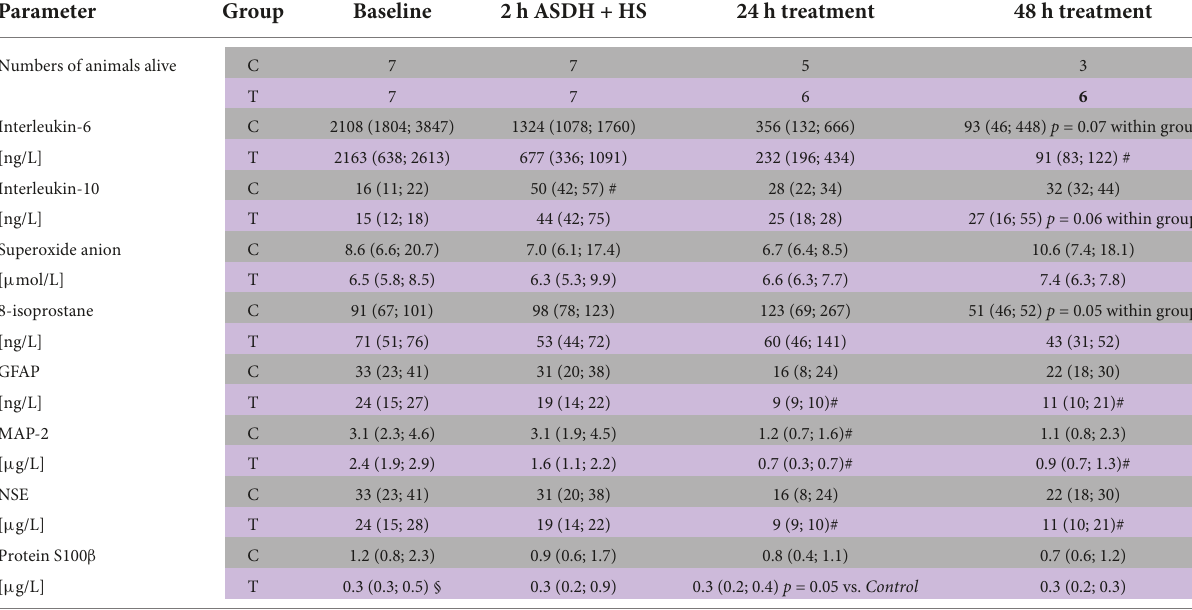
TABLE 3 Biomarkers of inflammation, oxidative stress, and brain injury. Parameter Group Baseline 2 h ASDH + HS 24 h